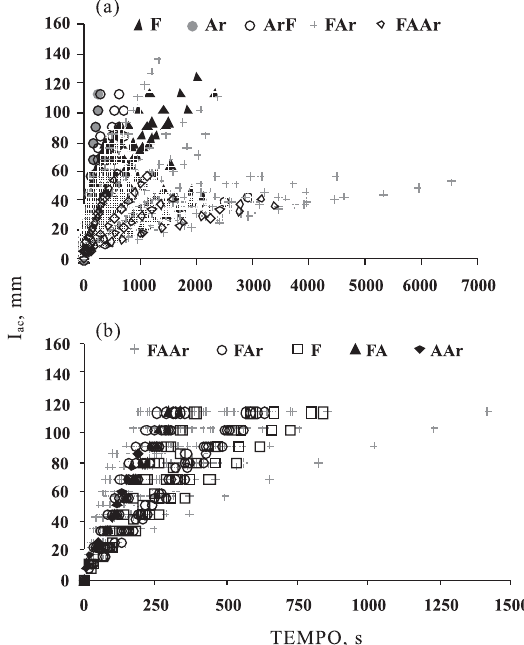
Figura 2. Infiltrações acumuladas em função do tempo para o Neossolo Flúvico (a) e Latossolo Amarelo